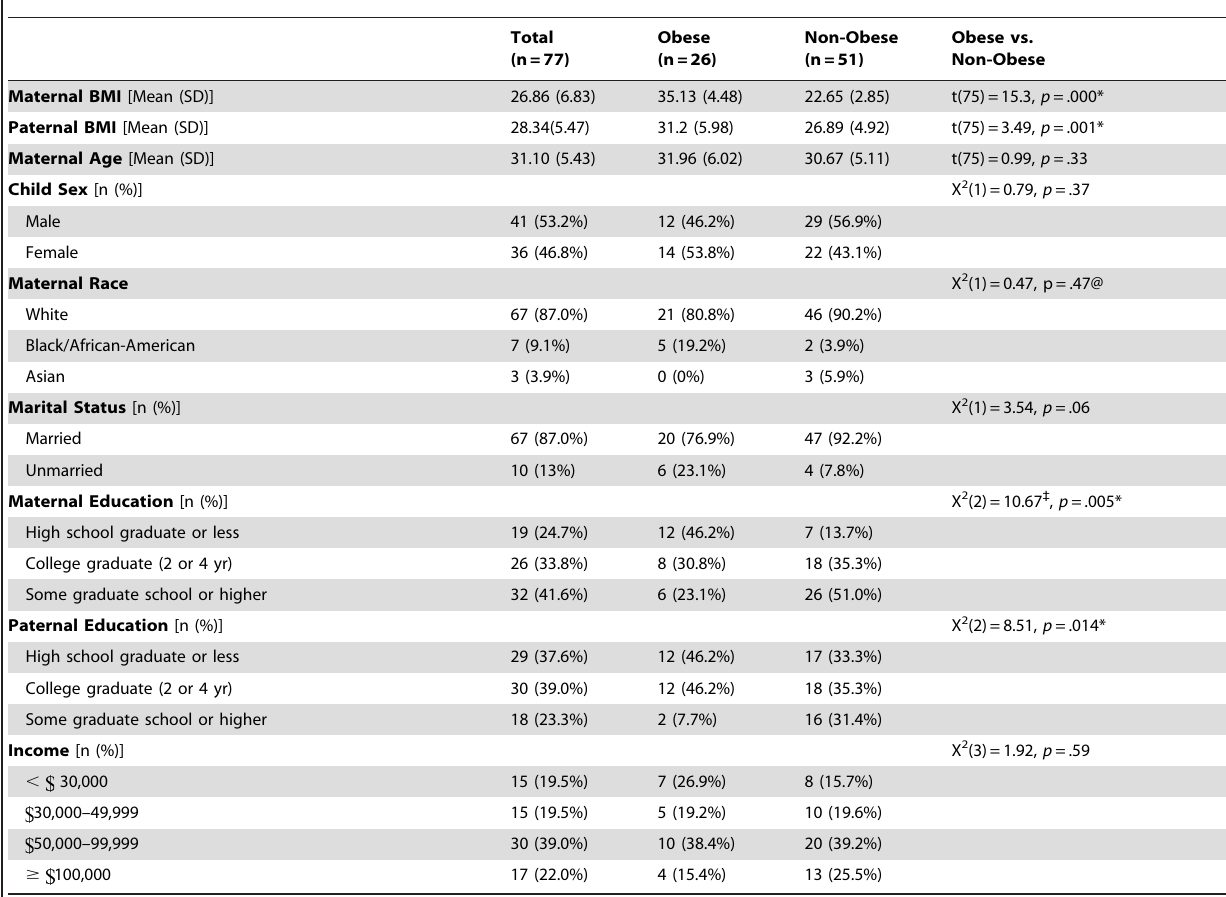
Table 1. Demographic